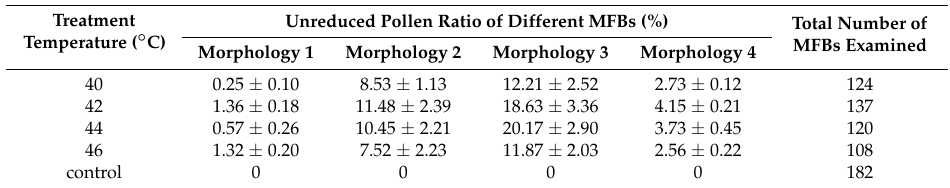
Table 3. Ratio of unreduced pollen for different external characteristics of MFBs and under different temperature exposures.